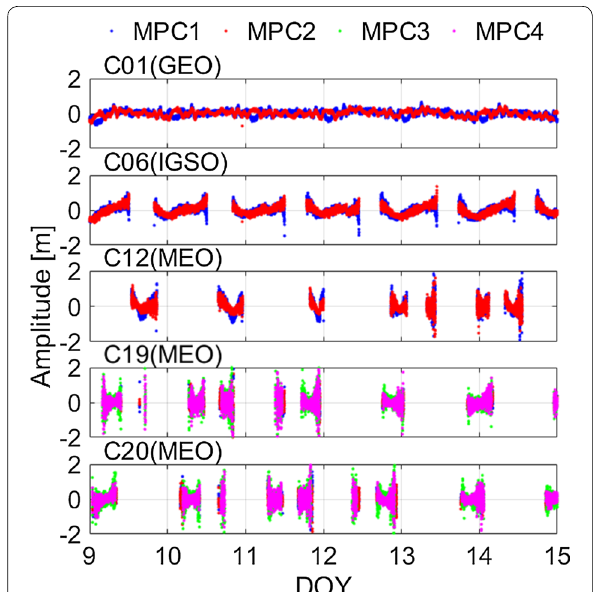
Fig. 2 MPCs of BDS B1I, B3I, B1C and B2a signals at iGMAS station XIA3 during DOY 9–14,